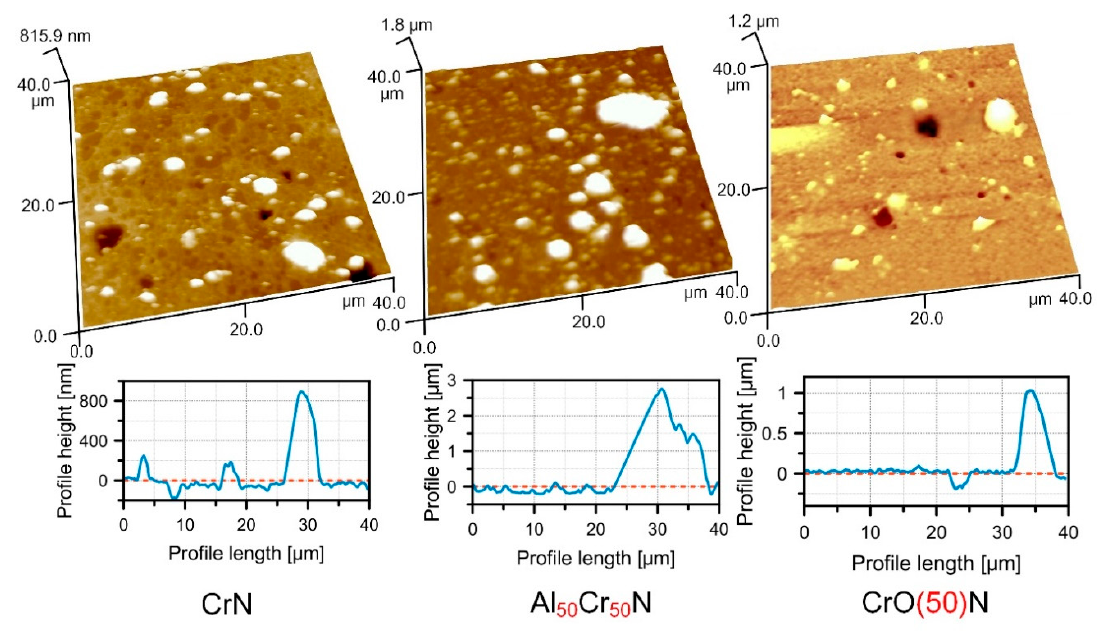
Figure 2. Three-dimensional atomic force microscopy (AFM) images and surface profiles of CrN, Al 50 Cr 50 N and CrO(50)N coatings with microparticles.